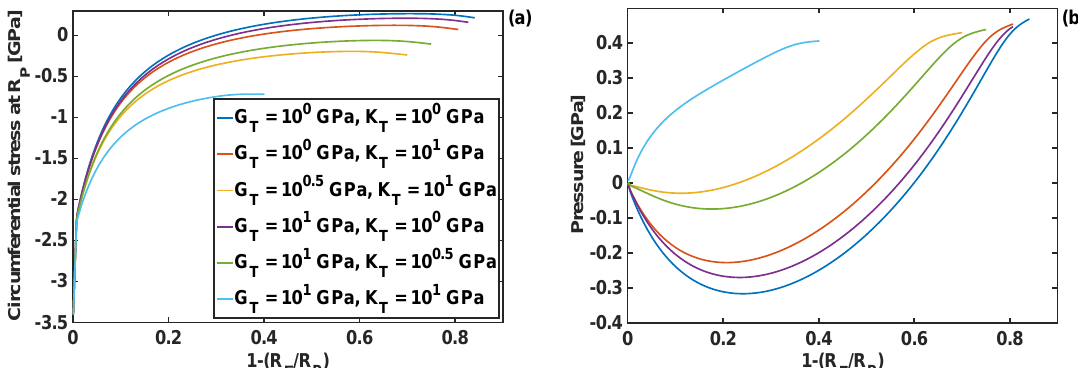
Figure 5: Circumferential stresses and pressure as functions of the reaction front position for different combinations of the coating moduli: ( a ) circumferential component; ( b ) pressure; h = 10 nm.